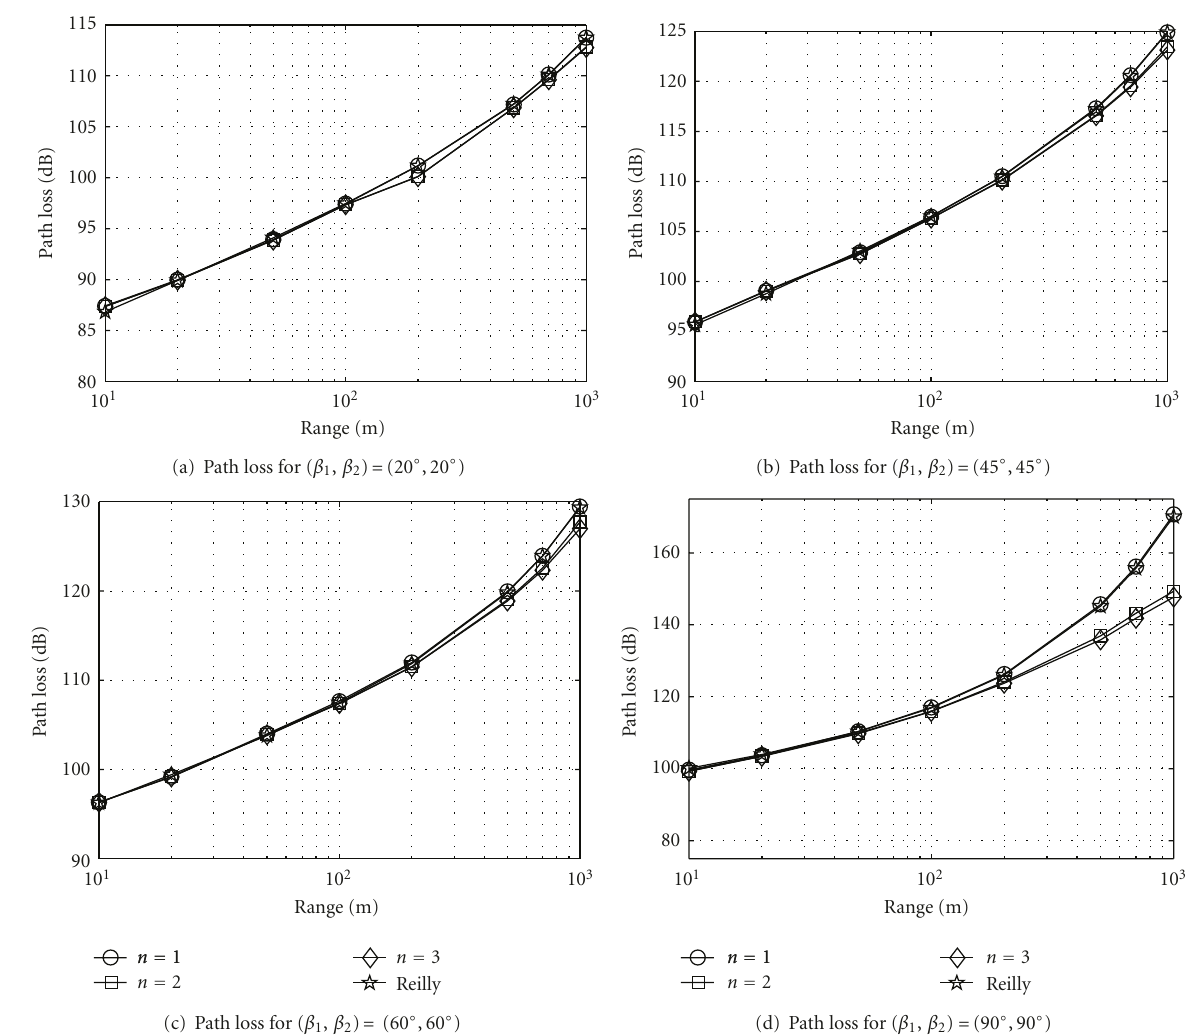
Figure 4: Path losses predicted by the proposed model and Reilly’s model